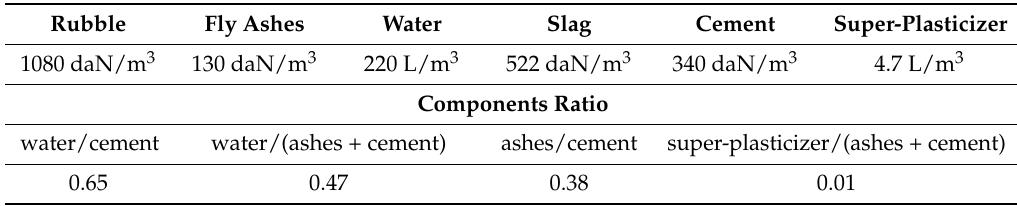
Table 2. Composition of slag and fly ashes (FA) concrete mix per unity of volume and ratios of the components.